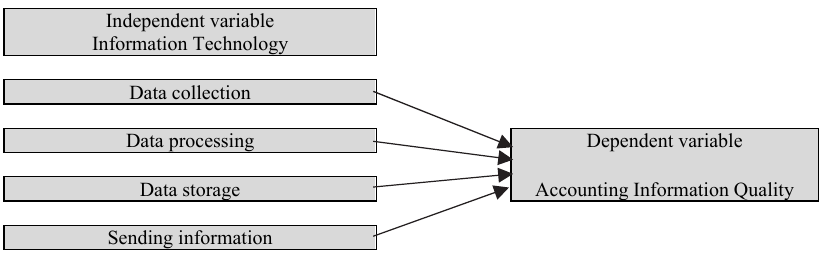
Fig. 1. Model and Variables of the